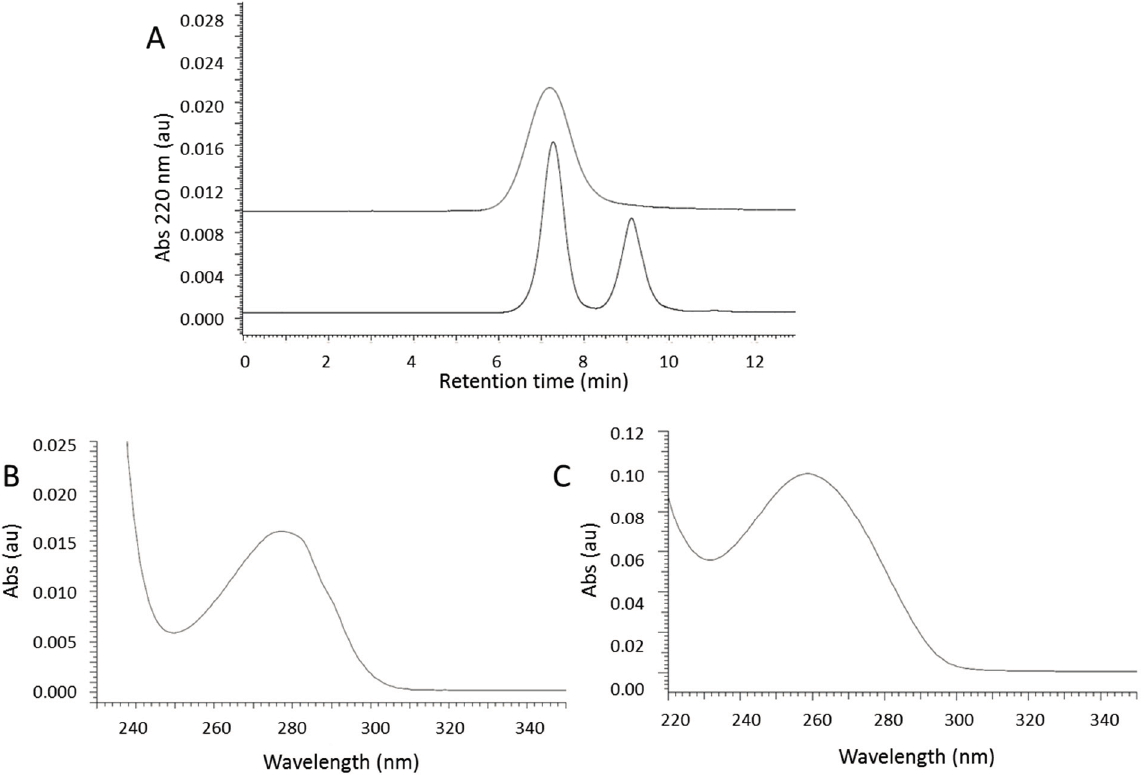
Figure 4. Selective cleavage of PMLA nanoconjugate followed by SEC-HPLC. ( A ) SEC-HPLC (upper trace) at 220 nm wavelength showing the nanoconjugate before cleavage indicated by a single broad peak. After cleavage, two peaks emerged (lower trace); The first peak shows the absorbance profile of Herceptin and a maximum at 280 nm wavelength ( B ); The second peak shows the absorbance spectrum for AON and a maximum at 260 nm ( C